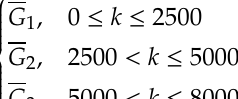
Figure 4. Pseudo partial derivative (PPD) estimation of each agent (example 1).